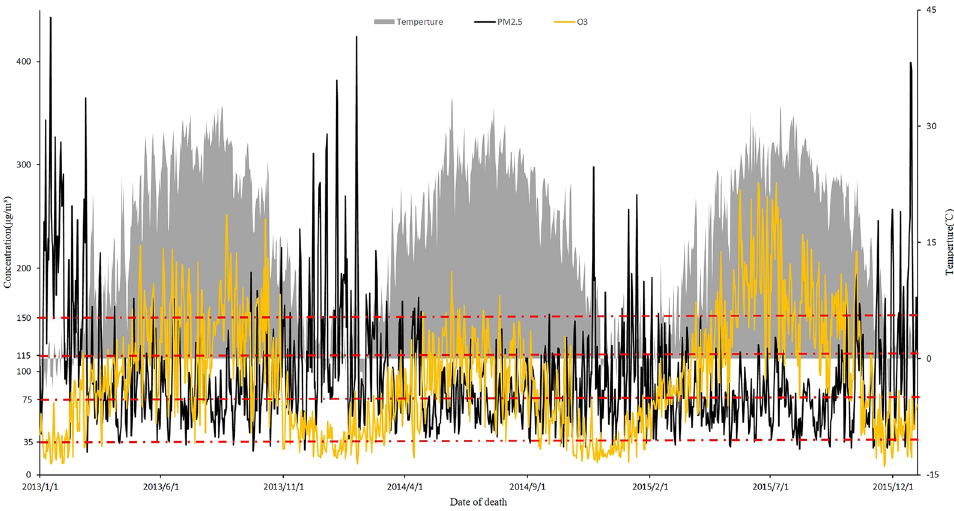
Figure 1. Distribution of daily ambient pollutant concentrations and temperature in Jinan, China, from 2013 to 2015.